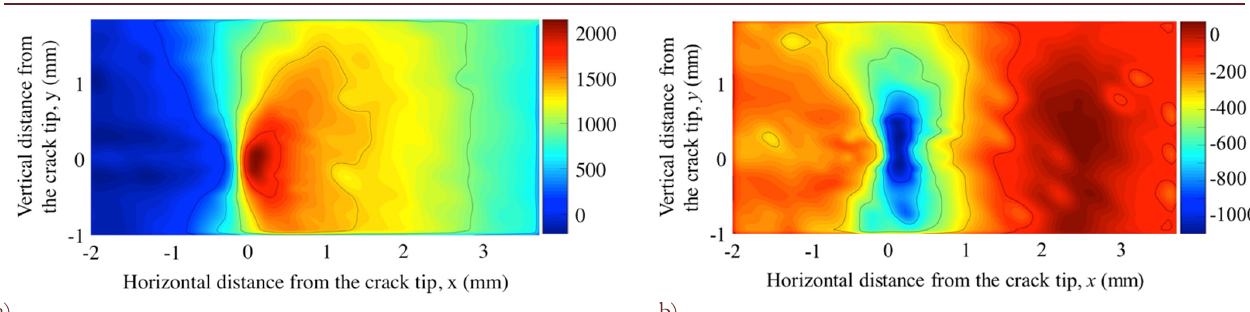
Figure 3: Mid-plane maps of stress in the loading direction  yy (in MPa) calculated from the elastic  xx and  yy measured by synchrotron XRD a) at OL (1. 7 K max ) b) immediately after OL at minimum load ( K min ). Note the different colours scales used.